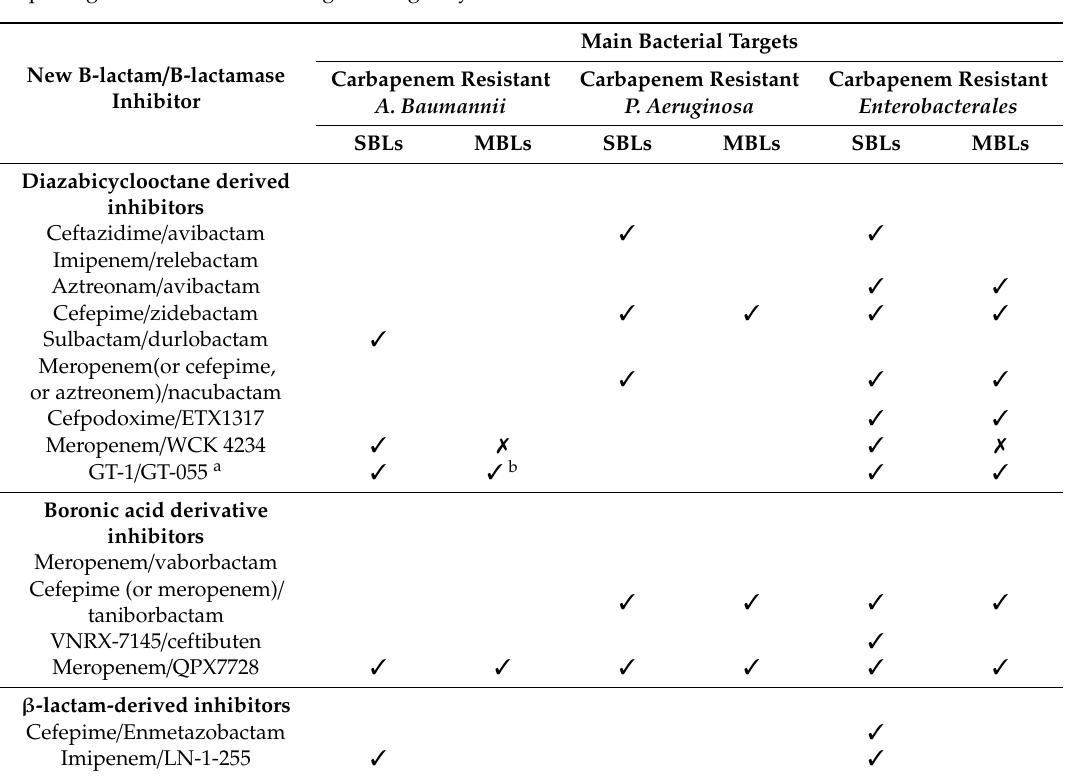
(cid:51) , useful inhibitory activity experimentally demonstrated; (cid:55) , non-inhibition or not useful inhibitory activity demonstrated; blank square, not evaluated. Intermediate inhibition activity: IC 50 or K i values: a K i = 4.5 µ M,